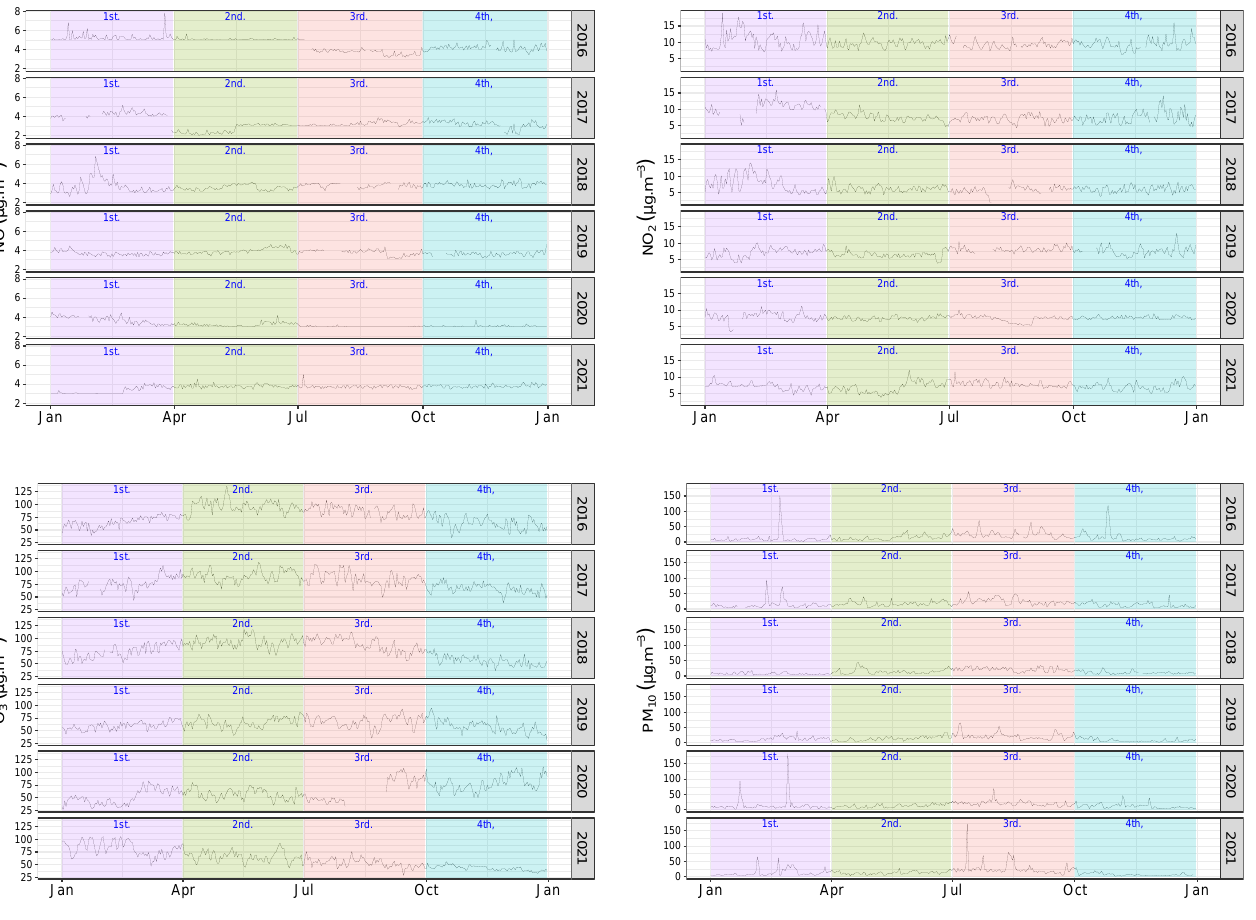
Figure 9. Evolution of the daily concentrations of NO, NO 2 , O 3 , and PM 10 at the Caravaca